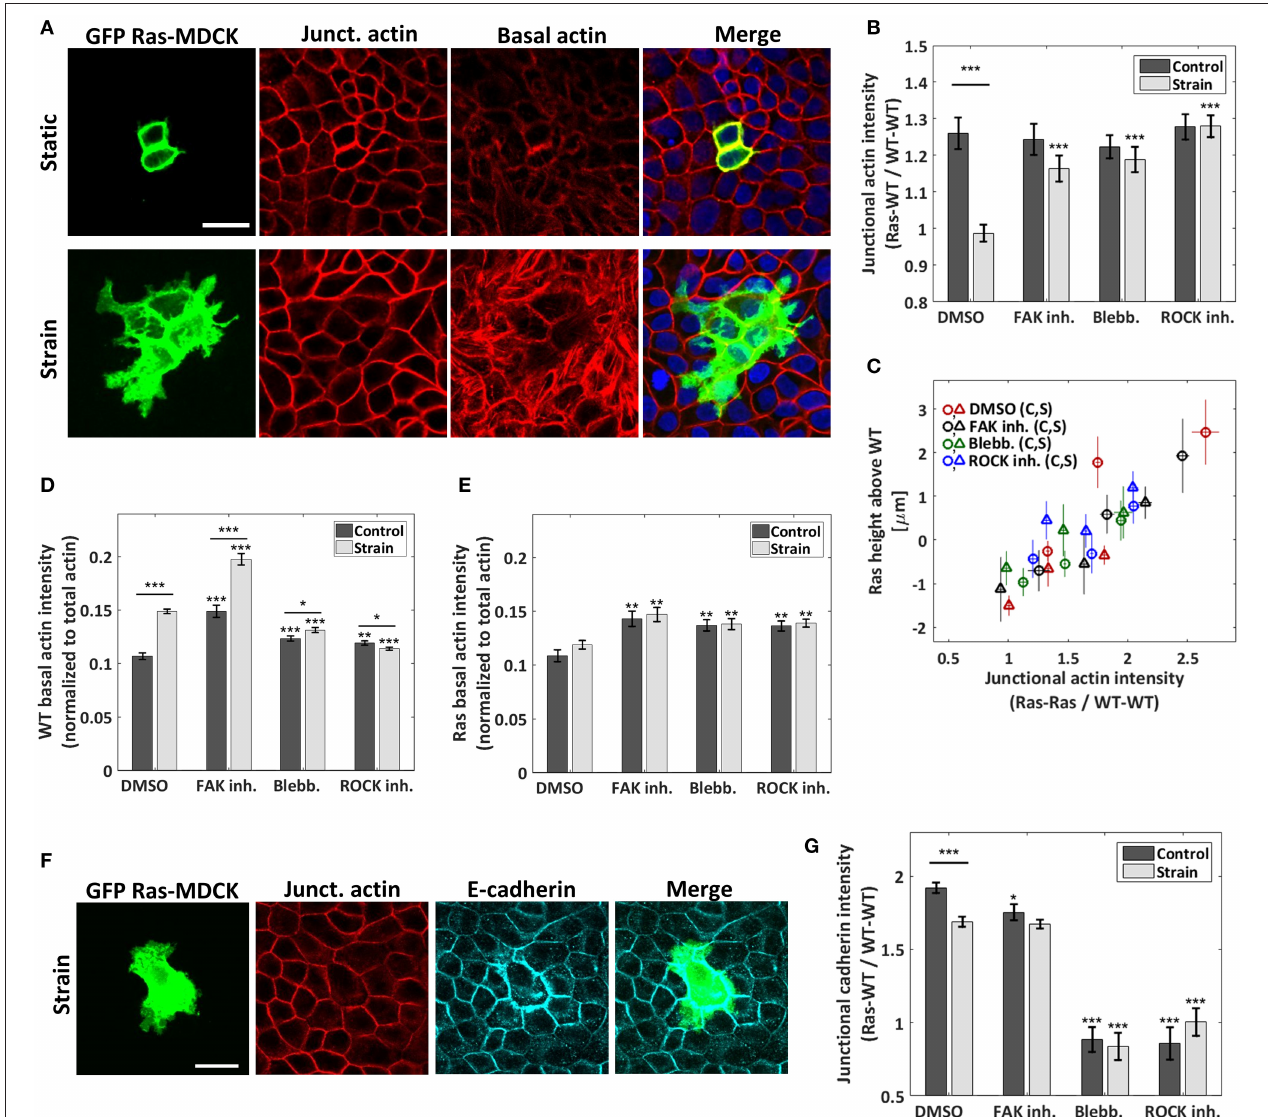
FIGURE 2 | Cyclic stretching promotes actin and e-cadherin reorganization differently in WT and in Ras V12 -transformed cells. (A) Confocal images of the Ras V12 -WT culture for a static control (top) and a stretched experiment (bottom). GFP-Ras V12 cells are in green. Junctional and basal actin images (red) were obtained as described in the sections Materials and Methods and S.2. Scale bar is 25 µ m. (B) Ratio of the junctional actin intensity, Ras V12 - WT interface over WT-WT interface. (C) Correlation between Ras V12 extrusion height and the junctional actin intensity ratio Ras V12 - Ras V12 over WT-WT. The data from each of the 8 conditions [DMSO and three drugs, static (c) and strain (s)] were separated in three bins each of equal number of cells. (D,E) Average basal actin intensity of the WT (D) and Ras V12 (E) cells. Both are normalized to the actin intensity summed over all stacks and averaged over the full image. (F) Representative confocal images of the Ras V12 -WT culture under strain showing a GFP-Ras V12 cell (green), junctional actin (red) and e-cadherin (magenta). Scale bar is 25 µ m. (G) Ratio of the e-cadherin junctional intensity, Ras V12 -WT interface over WT-WT interface. For (B,D,E,G) , three drugs were tested in addition to the drug-free case (DMSO): FAK inhibitor, blebbistatin, and ROCK inhibitor. Data are mean ± s.e.m. *** P < 0.0001, ** P < 0.005, * P < 0.05. Stars above the individual bars relate to the corresponding DMSO control or DMSO strain condition. Stars above the horizontal lines refer to the significance between the control and strain data. From left to right, n = 43, 48, 29, 44, 56, 56, 53, and 57 images, each from 3 to 4 independent experiments. The average ratios of each image were compiled and they were used to determine the mean and the s.e.m. of the data points reported; the total number of Ras V12 cells contained in each set of images is given in Figures 1E,F